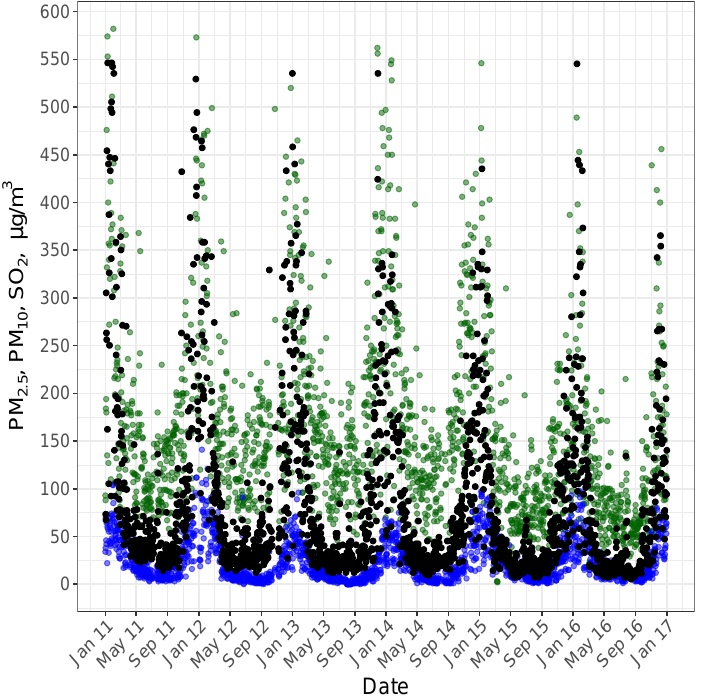
Figure 2. Daily concentrations of PM 2.5 (black), PM 10 (green), and SO 2 (blue) at one of two UB sites measuring all three pollutants from January 2011 through December